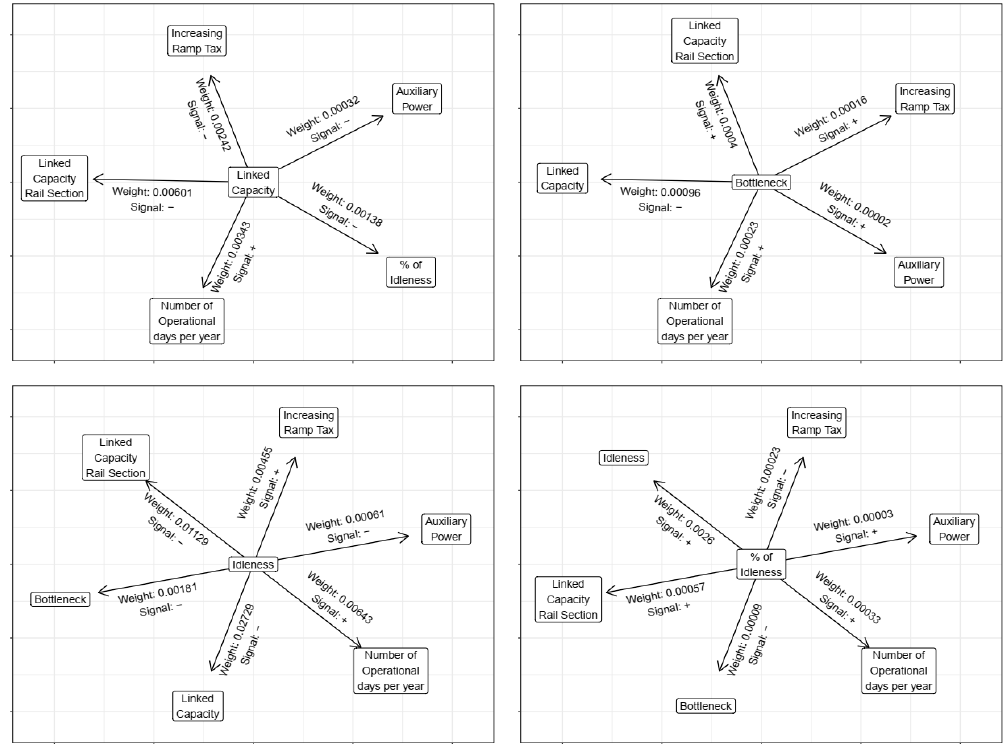
Figure 11. Cause and effect framework for selected attributes at 0.975 percentile (weights are derived from step 2, signs are derived from Olden and Jackson’s (2002) [48] sensitivity analyses).